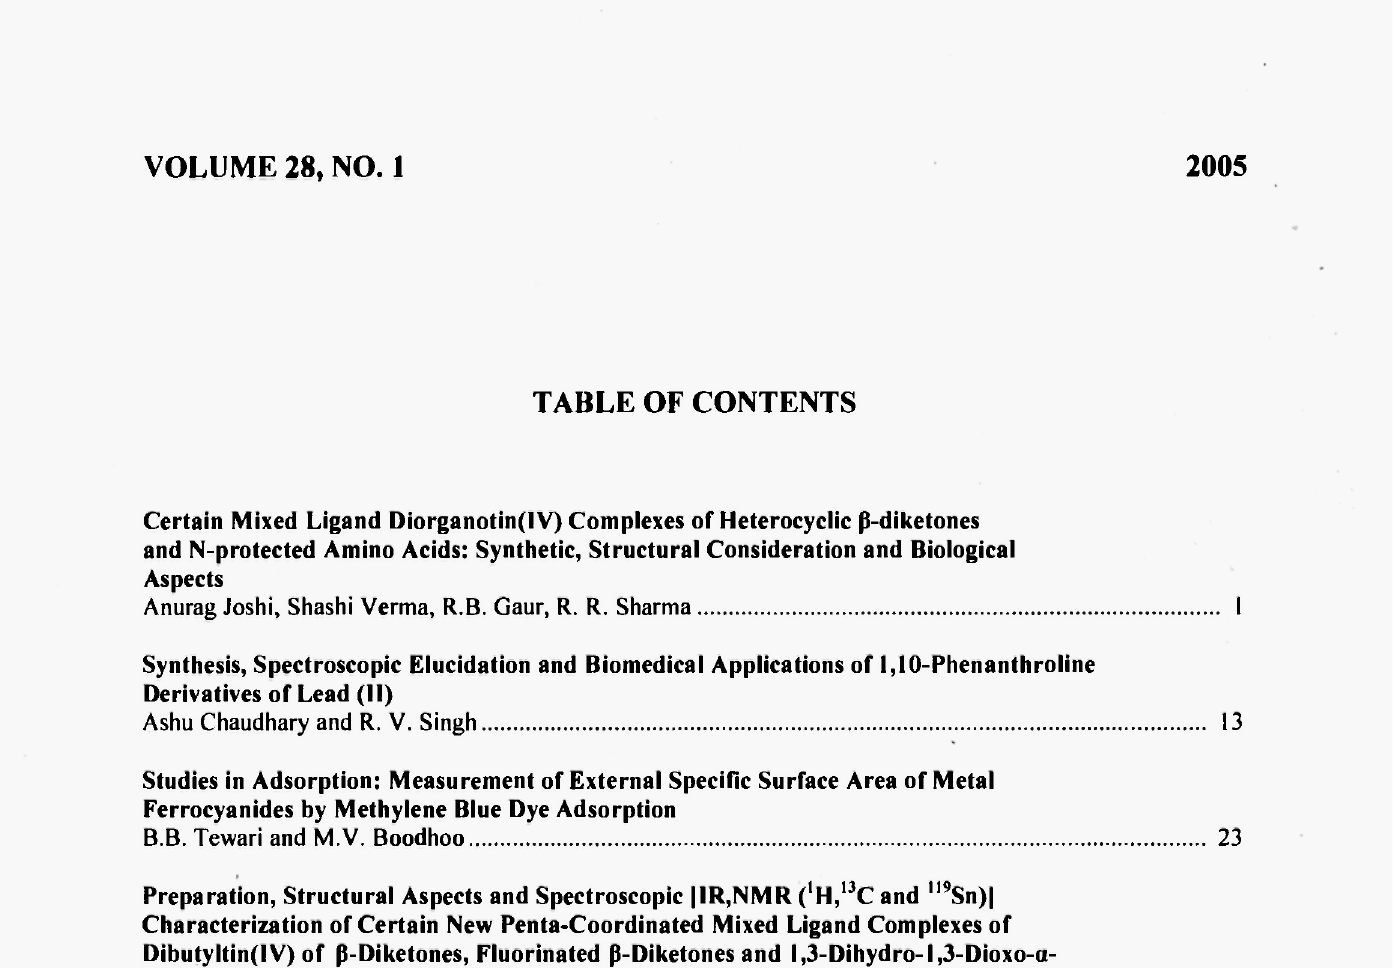
Preparation, Structural Aspects and Spectroscopic |IR,NMR ('H, 13 C and ,l9 Sn)| Characterization of Certain New Penta-Coordinated Mixed Ligand Complexes of Dibutyltin(IV) of ß-Diketones, Fluorinated ß-Diketones and l,3-Dihydro-l,3-Dioxo-a- Substituted-2H-lsoindole-2-Acetic Acids